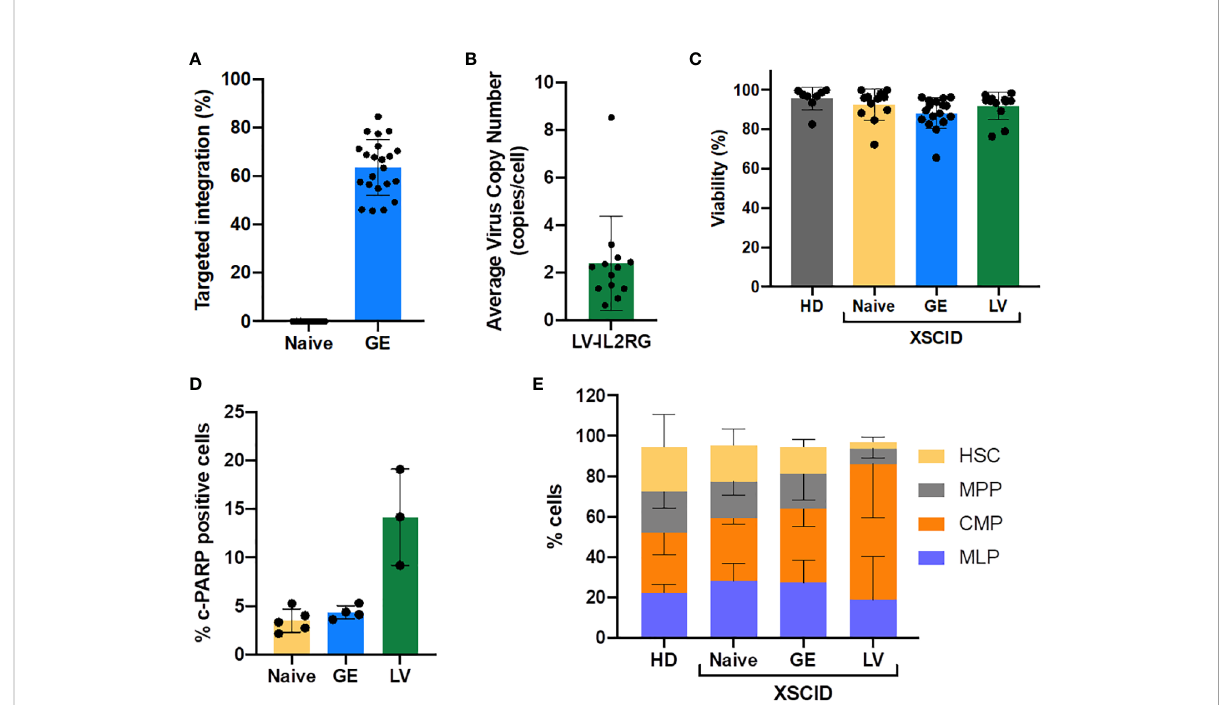
FIGURE 1 Ef fi cacy of CRISPR-Cas9-AAV gene editing and LV-transduction and impact on the cell fi tness. Frequency of TI of IL2RG after gene editing (GE) (A) and the average VCN after LV-transduction (B) into HD and XSCID patients CD34 + HSPCs, as determined by ddPCR. Each symbol depicts a sample, from9-14 independent experiments, 6 individual patients. (C) Cellviability of CD34 + XSCIDHSPCsmeasured by trypan blue exclusionat 2 days post GEor LV-transduction. (D) c-PARP1expressionmeasured by fl ow cytometryat 24h post-treatment ofCD34 + XSCIDHSPCs; n=3-5 independent experiments. (E) Repartition ofCD34 + subpopulations at day2post treatment; n=3-5 independent experiments (1HD, 2 XSCID